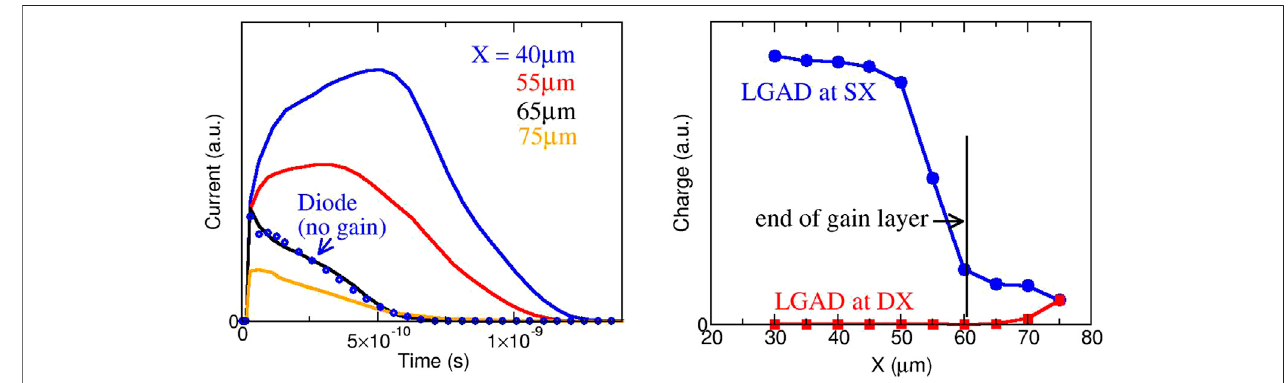
FIGURE 8 | Left, simulated current pulses at the left electrode (SX) of Figure 7 generated by mips crossing the device vertically at position X as speci fi ed in the legend. Solid lines are for an LGAD with gain of 10, the dotted line is for the case of a mip crossing the diode at X (cid:2) 40. Right, charge calculated as the integral of the current pulses produced by mips traversing the silicon at X, and induced at the electrode on the left (SX) and on the right (DX).